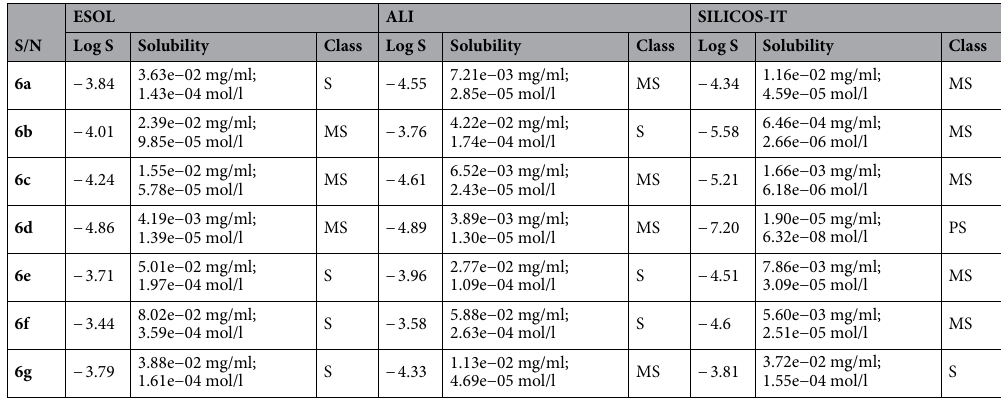
Table 3. Water solubility. S soluble, MS moderately soluble, PS poorly soluble.